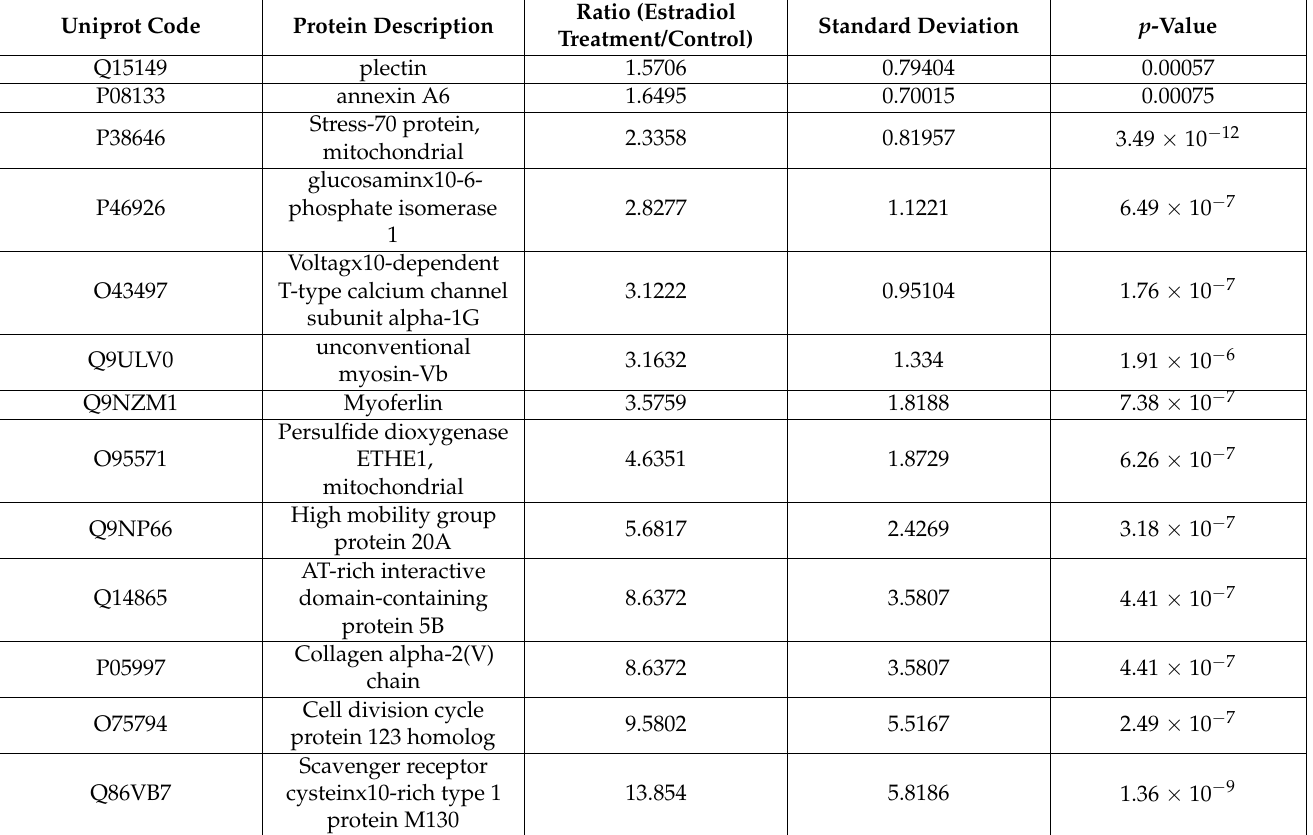
Table 2. Top ten upregulated proteins by Estradiol in MSCs and extracted using Proteome Discoverer Software. Uniprot